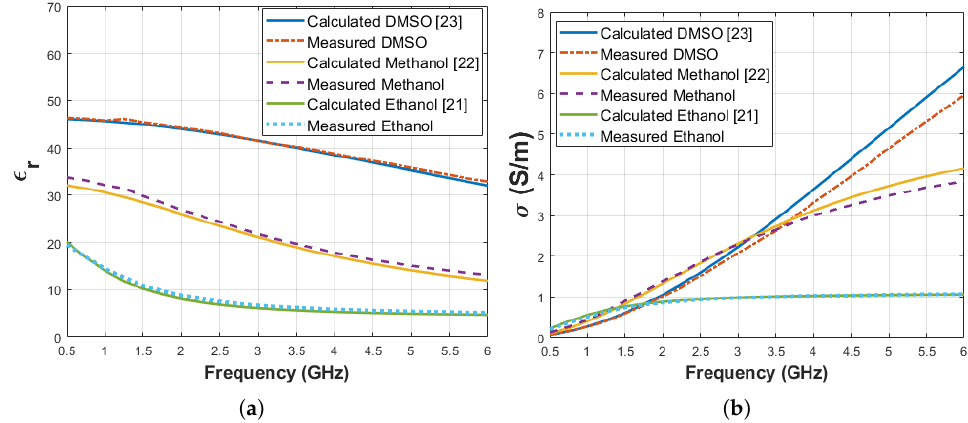
Figure 5. Comparison of known materials (ethanol, methanol and DMSO) dielectric properties calculated from Debye parameters obtained from the literature and measured by the experiment setup: ( a ) relative permittivity, ( b ) conductivity. Table 2. Maximum dielectric property difference between measurements and Debye model calcula- tion for known materials (ethanol [21], methanol [22] and DMSO [23]) used for system validation. Materials Difference for (cid:101)